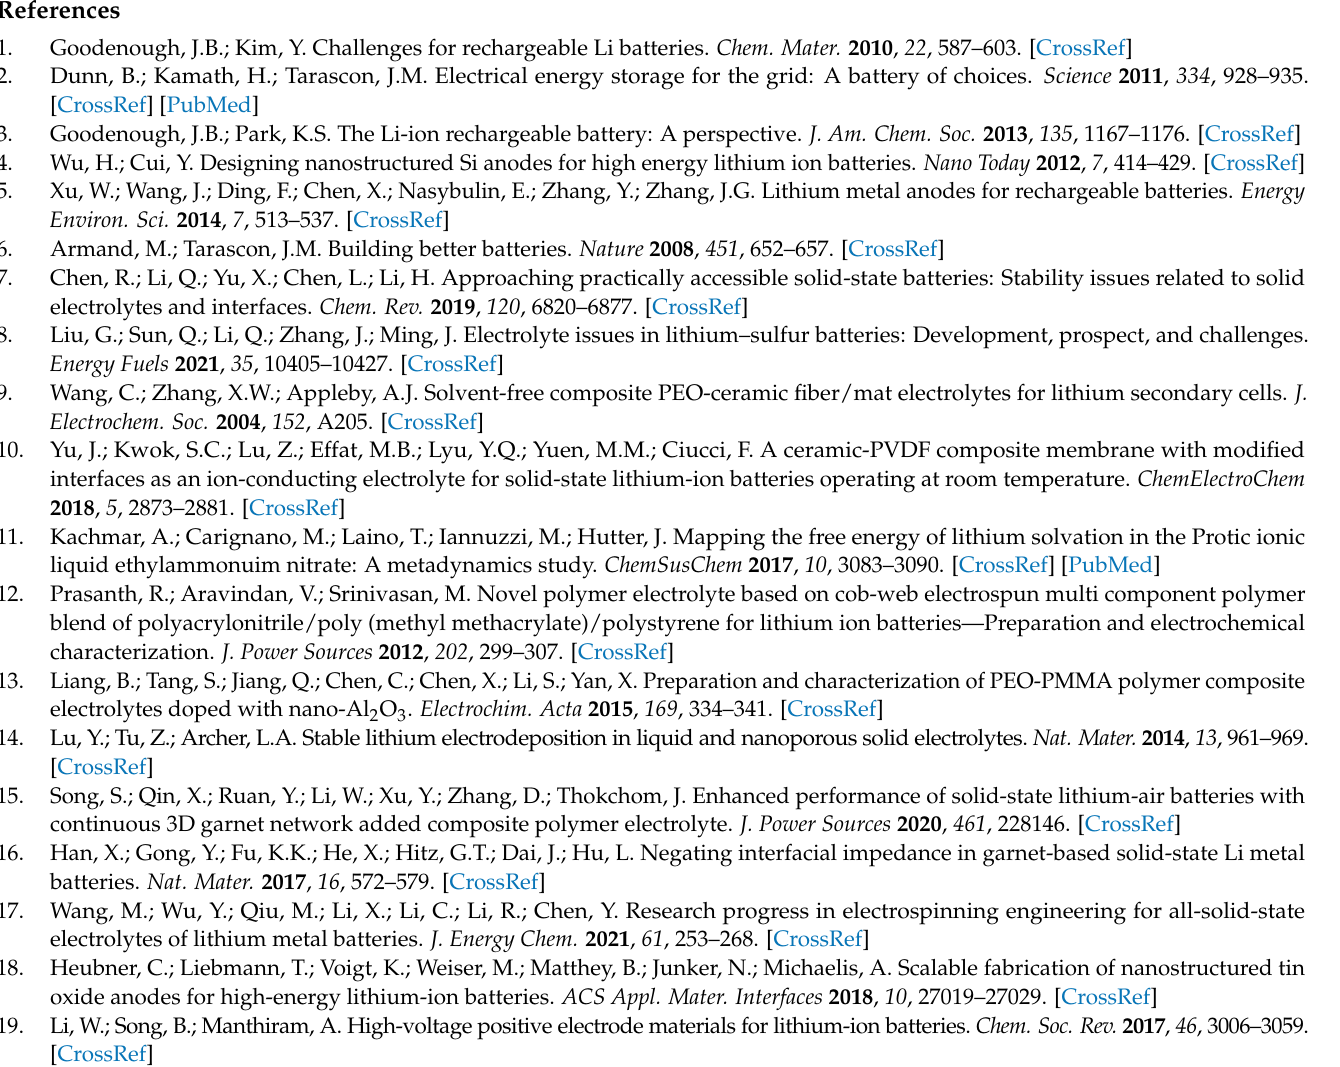
S4: The temperature depend–ency of ionic conductivity of CPE and GCPE; Figure S5: Ymmetric-cell cycling of Li/CPE/Li (red line) and Li/GCPE/Li (black line). The current density was fixed at 0.5 mA cm − 2 during the tests; Figure S6: SEM of CPE and GCPE before and after cycling for 700 h; Figure S7: The EIS of LFP/CPE/Li battery for different aging time; Figure S8: Cycle perfor–mance of LFP/Pes/Li at at room temperature and 0 °C; Table S1: Element content of selected area for Figure S2a (CPE/Li); Table S2: Element content of selected area for Figure S2b (CPE/Li); Table S3: Changes of resistance values of each part before and after Li/CPE/Li and Li/GCPE/Li cycles for Figure